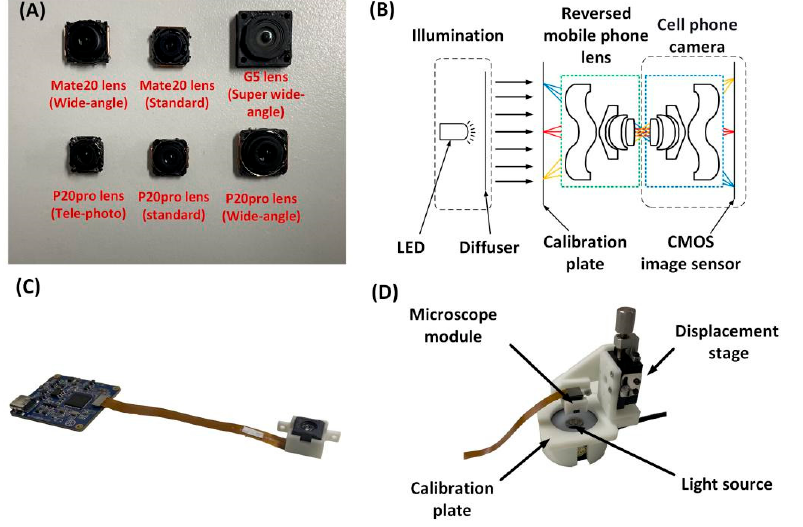
Figure 2. Measurement of selected off-shelf cell phone camera lens. ( A ) The six cell phone lenses with distinct focal lengths are all obtained from disassembled cell phones of Huawei P20pro, Mate20, and LG G5. ( B ) The focal length measurement device consists of a diffused light source, calibration plate, the lens to be measured and a camera module with known parameters. ( C ) The image of the tube lens camera module with known focal length and Sony IMX258 sensor. ( D ) The experimental system consists of a microscope module, displacement stage, calibration and light source. The frame is produced by 3D printing.